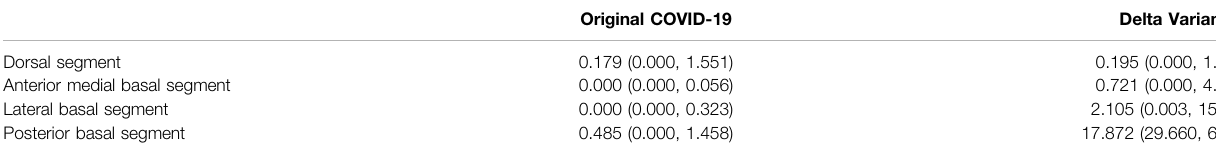
TABLE 1 | POI values in lung segments of the left lower lobe.